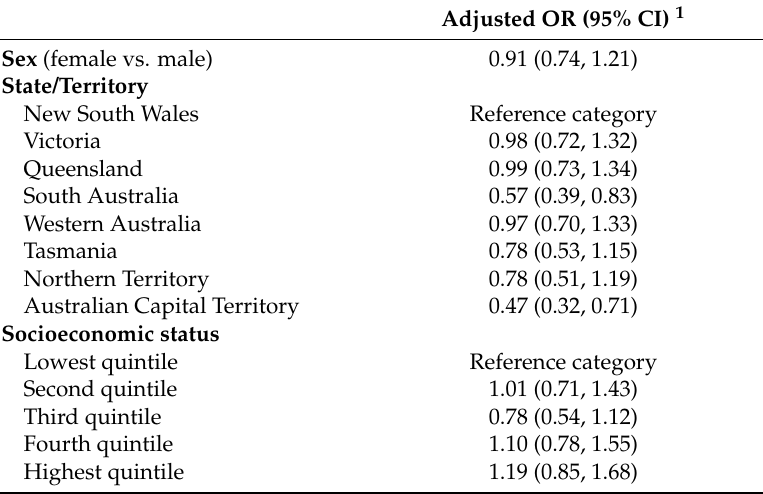
Table 3. Adjusted logistic regression investigating independent predictors of dietary supplement use in Australian children aged ≤ 9 years ( n =